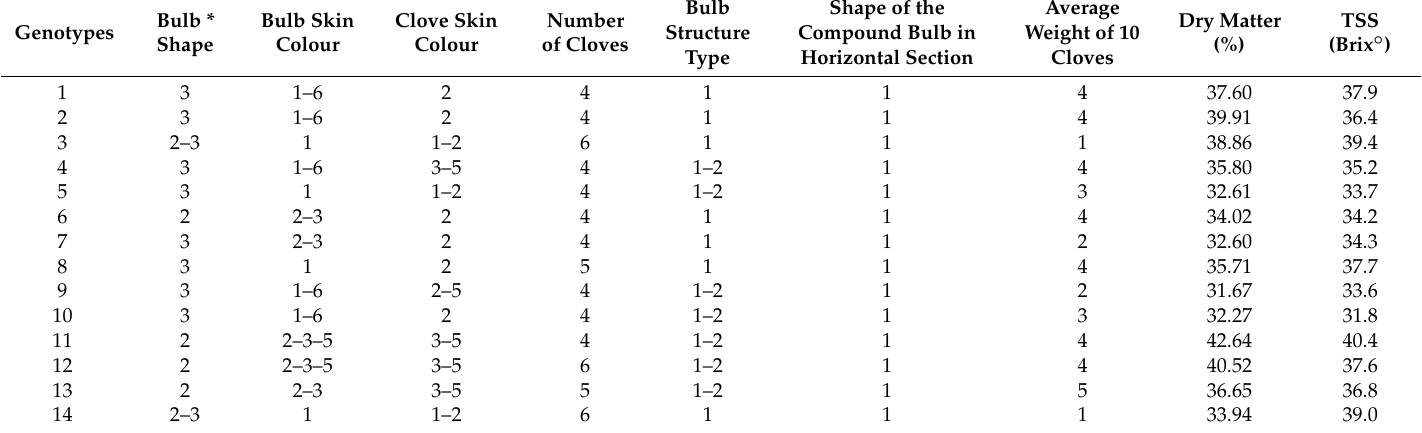
Table 1. Morphological features of dry bulbs of the studied garlic genotypes according to International Plant Genetic Resources Institute (IPGRI, 2001)